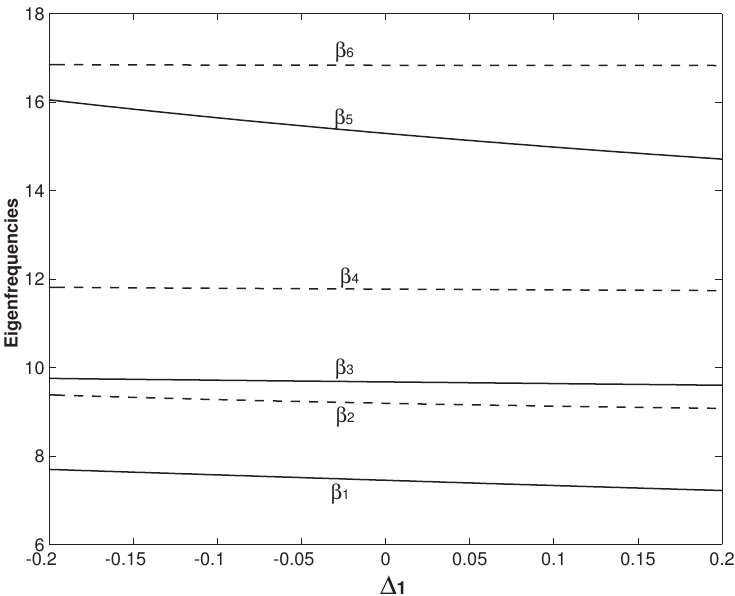
Figure 10. The first six eigenfrequencies as the functions of ∆ 1 . The overhang length is fixed as ξ 1 = ξ 2 = 0.265, which is around the veering locus No. 1 in Figure 8. Except ∆ 1 , ξ 1 and ξ 2 , all other parameters are the same as those in Figure